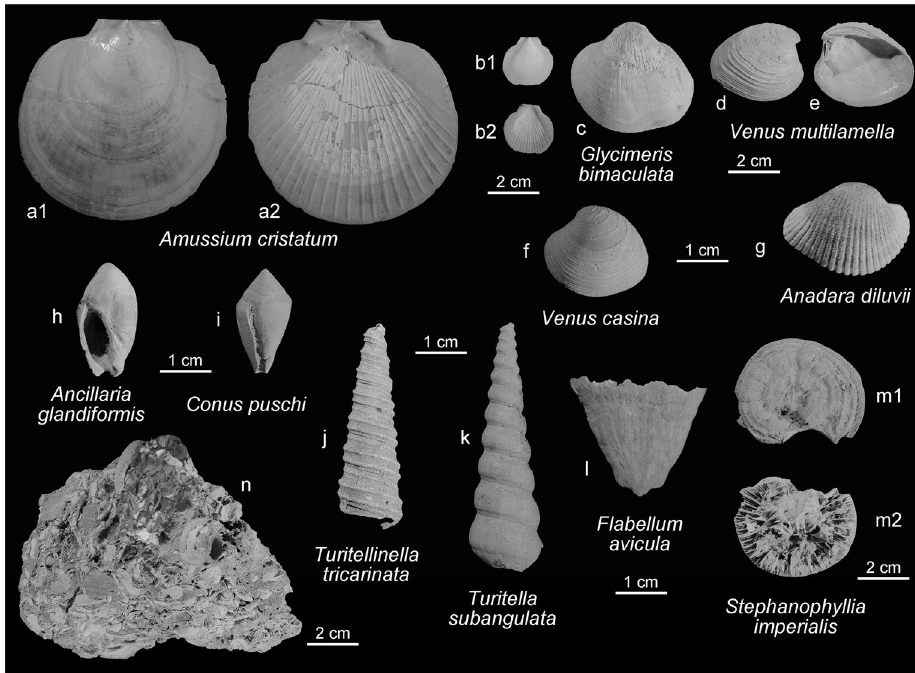
Fig. 7 Photoplate of selected macrofossils from the Early Pliocene coquina of section 1, ca. 1.5 km south of Dar bel Hamri. A rock sample is shown in